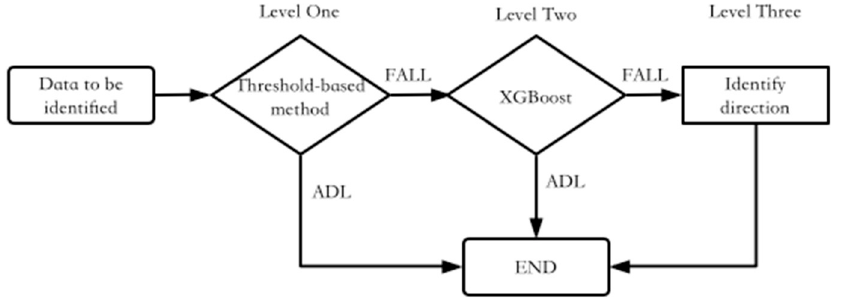
Figure 6. The model of fall detection.